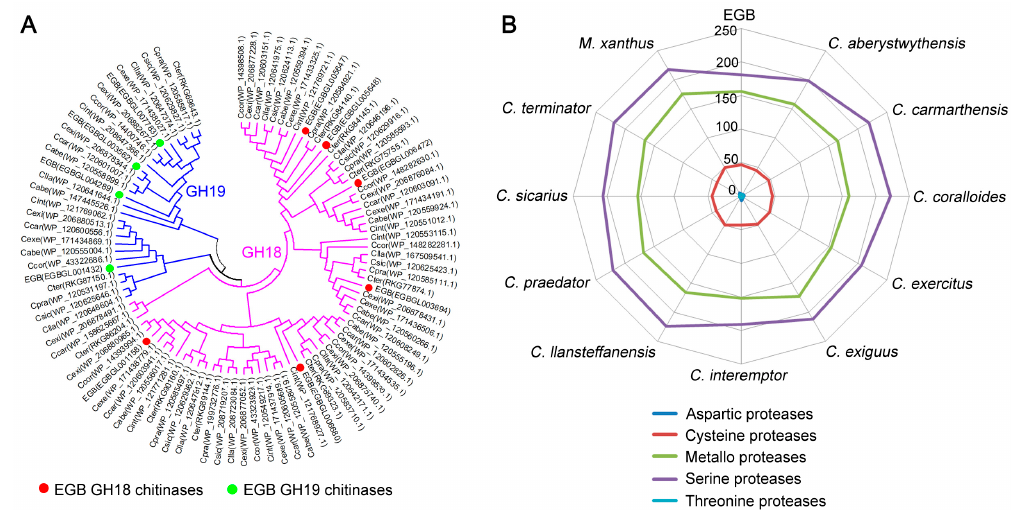
Figure 5. Comparison of chitinases and proteases. ( A ) Phylogenetic tree of chitinases derived from strain EGB, C. coralloides , C. praedator , and M. xanthus . ( B ) Comparison of protease numbers among Corallococcus species.